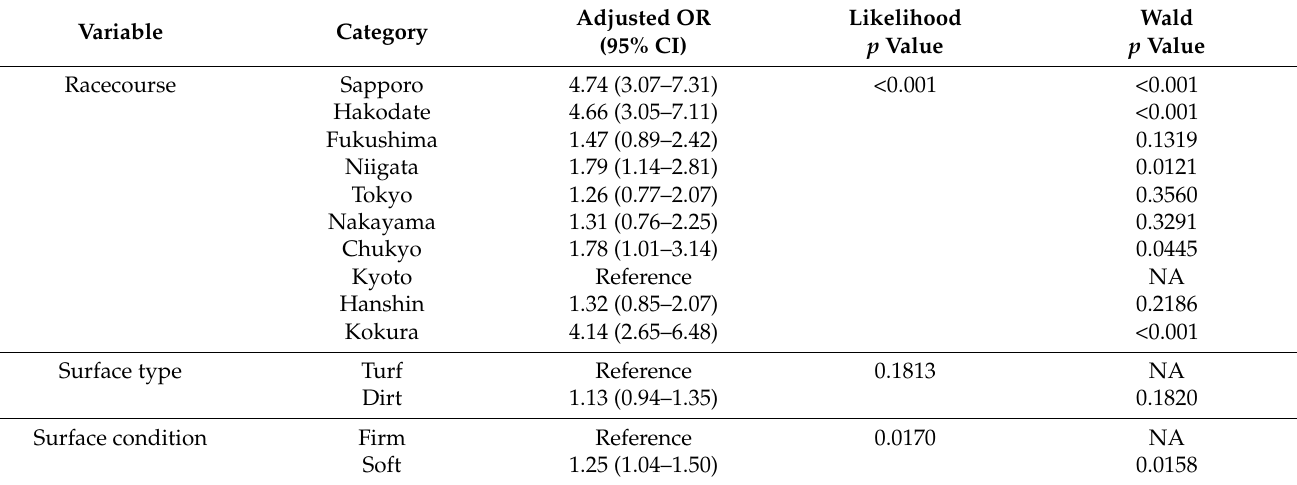
Table 3. The variables chosen by the stepwise procedure, and the result of multivariable logistic regression for epistaxis among horse racings in flat races. OR, odds ratio; CI, confidence interval; NA, not